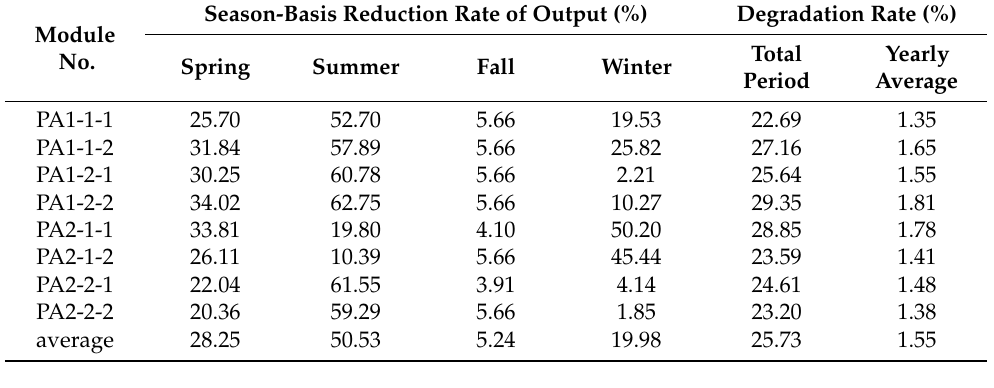
Table 6. Degradation rate of aged PV modules.